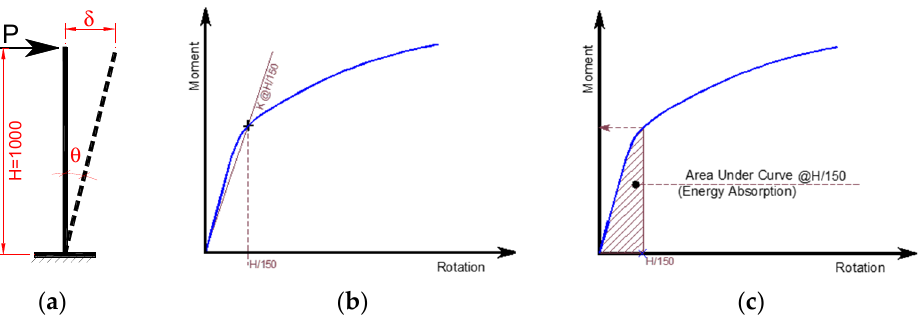
Figure 9. Schematic for calculating the ( a ) rotation θ = δ /H, ( b ) rotational stiffness K = M/ θ , and ( c ) moment and energy at certain value of rotation.